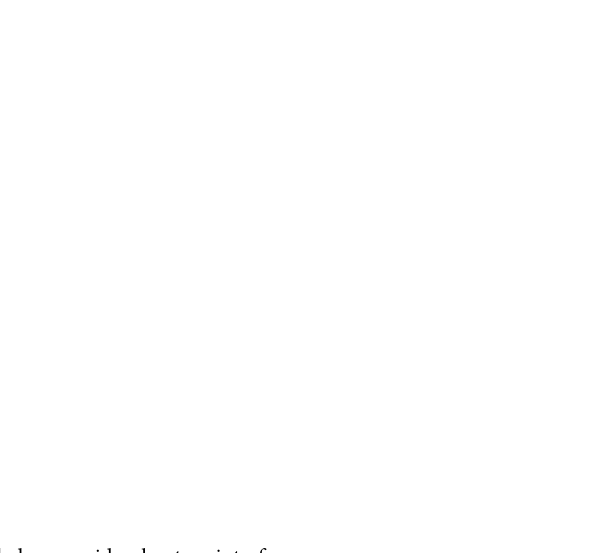
Figure 3. Simulation setup of the open-ended waveguide-phantom